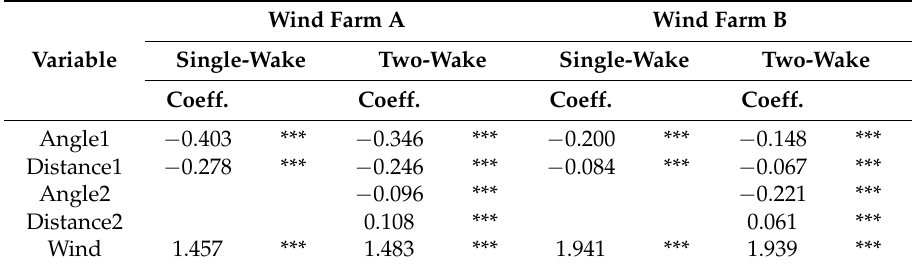
Table 4. Estimation results: average marginal effects (changes due to 1% change in variables). Wind Farm A Wind Farm B Single-Wake Two-Wake Single-Wake Two-Wake Variable Coeff. Coeff. Coeff. Coeff. Angle1 − 0.403 *** − 0.346 *** − 0.200 *** − 0.148 *** Distance1 − 0.278 *** − 0.246 *** − 0.084 *** − 0.067 *** Angle2 − 0.096 *** − 0.221 *** Distance2 0.108 *** 0.061 *** Wind 1.457 *** 1.483 *** 1.941 ***